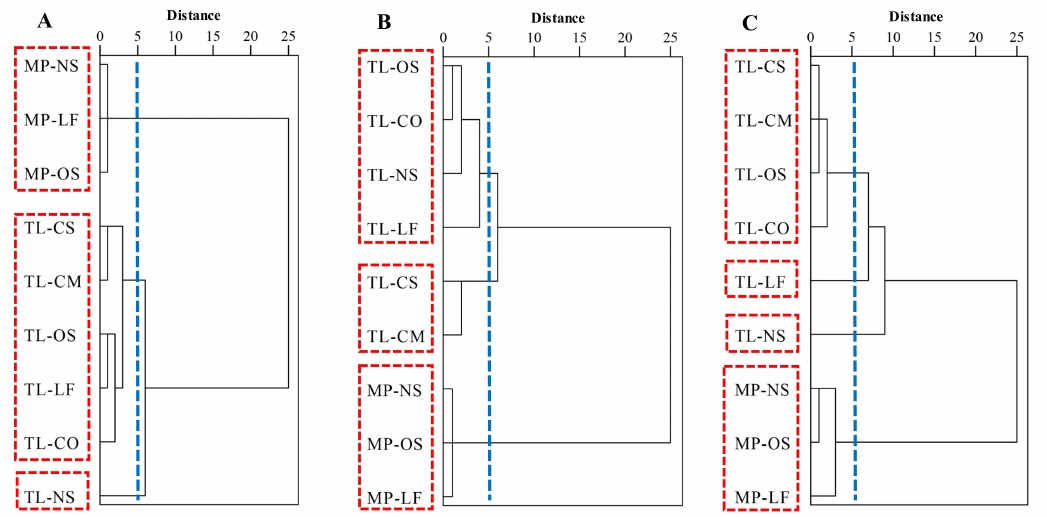
Figure 3. Hierarchical clustering using Ward’s method based on the water quality characteristics in various sampling sites in September ( A ), October ( B ), and December ( C ). The horizontal vertical axis shows the distance between sampling sites based on Euclidean distance. The abbreviations of the sites are the same in Figure 1.